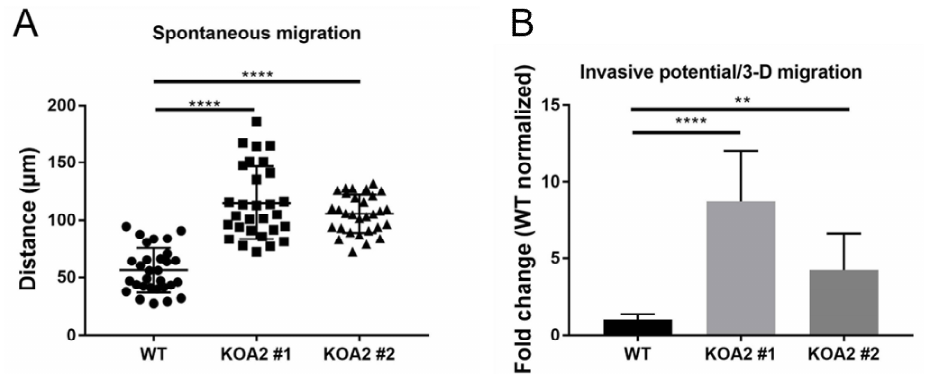
Figure 7. SLC35A2 deficiency enhances migratory and invasive properties of MDCK cells. ( A ) Results of the spontaneous migration assay. The cells were seeded into the wells of a 96-well ImageLock plate and monitored for 72 h with the IncuCyte system. Next, trajectories of single cells ( n = 30) were plotted and distance traveled by the moving cells was assessed. ( B ) Results of the in vitro invasion assay ( n = 10). Data are expressed as mean ± SD. Asterisks indicate statistically important differences between wild-type cells and individual clones. The significance level was set at p = 0.0095 (**) and p = 0.0001 (****). Data presented in both panels were analyzed using ordinary one-way ANOVA with post hoc (Dunnett’s multiple comparison) test.